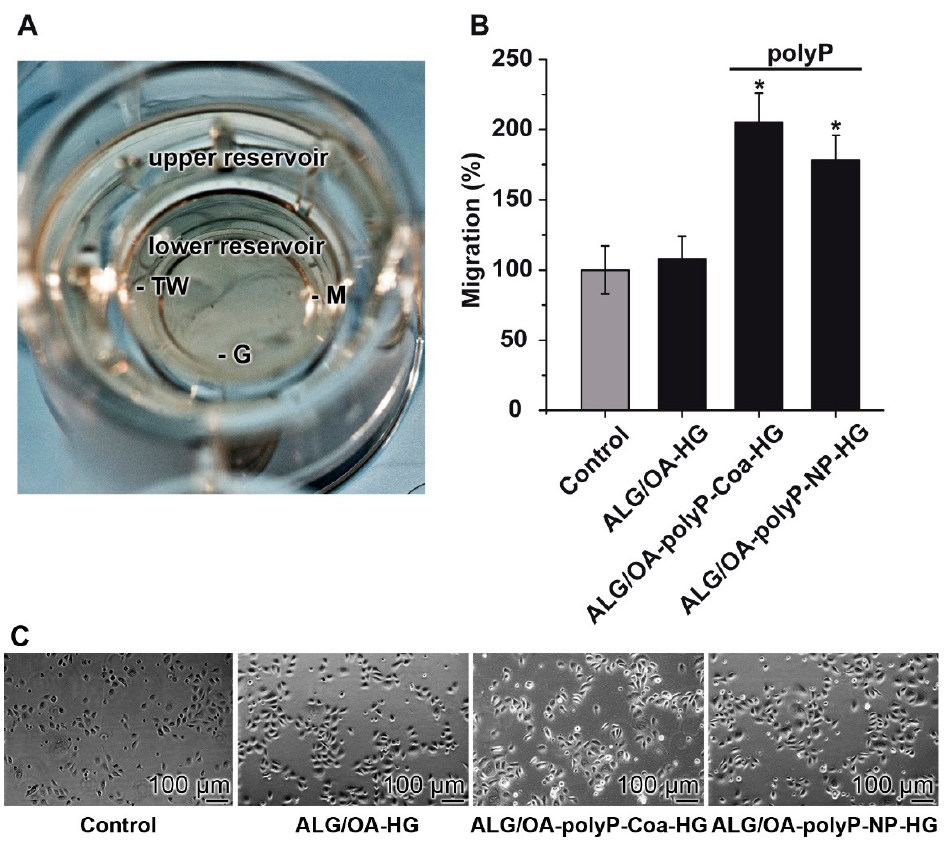
Figure 6. Determination of the migration activity of keratinocytes in the Boyden chamber. ( A ) Image of the Boyden chamber. The cells were placed into the upper reservoir, a transwell insert (TW), which is connected with the lower reservoir by a porous membrane (M). On the bottom of the lower reservoir, the hydrogel (G) is introduced. Attracted by the polyP released from the gel the cells migrate through the membrane. ( B ) Increase of the migration activity of keratinocytes in those assays into which the polyP-containing hydrogels, either “ALG/OA-polyP-Coa-HG” or “ALG/OA-polyP-NP-HG” had been added to the lower chamber. The migration activity is correlated with the one measured in the controls (without any hydrogel; set to 100%). Addition of the polyP-lacking “ALG/OA-HG” hydrogel to the system did not influence the activity (*; p < 0.01). ( C ) Light micrographs of the cells on the bottom side of the membrane (invasive cells) prior to fixation.